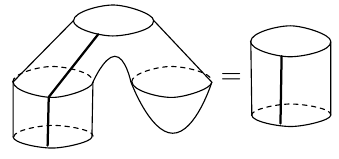
Figure 43 . A morphism can be moved across the product.